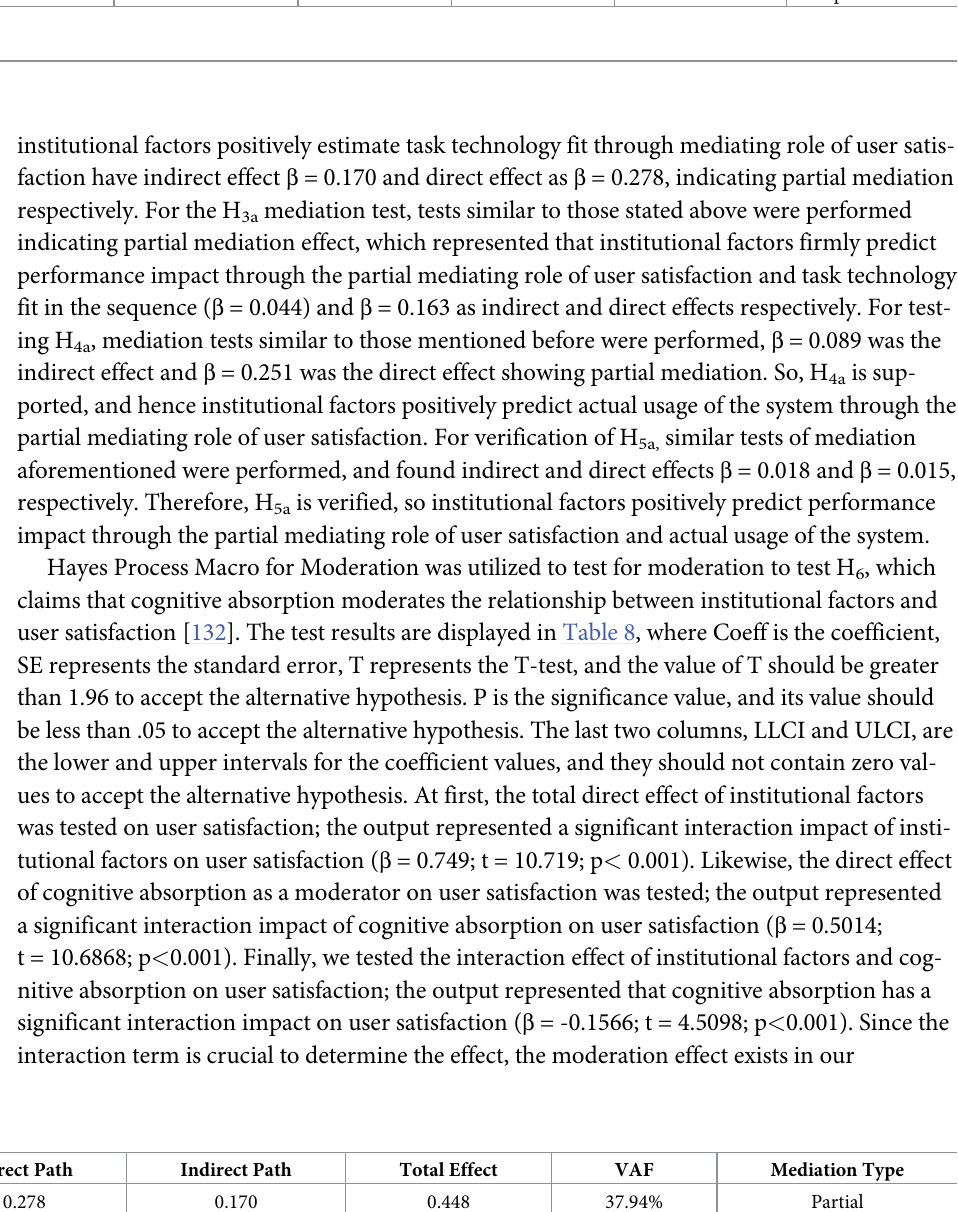
Table 7. Results of mediating effects.